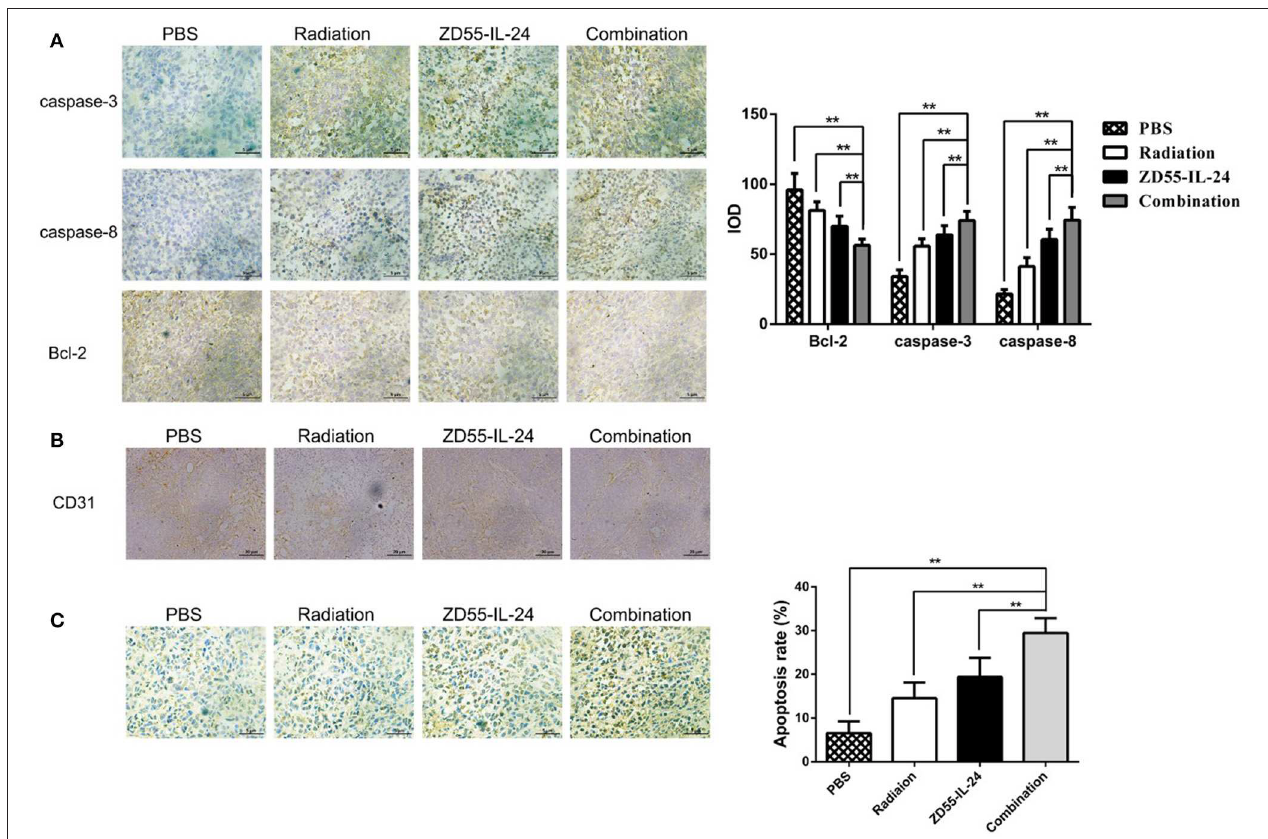
FIGURE 5 | Combination of ZD55-IL-24 and radiation induced the apoptosis of xenografts. (A) Immunohistochemistry staining of Bcl-2, caspase-3, and caspase-8 in xenografts of different groups (400 × ). (B) CD31 staining of xenografts in each group of mice. (C) TUNEL staining of apoptotic cells in xenografts of different groups (400 × ). 1, PBS; 2, radiation; 3, ZD55-IL-24; 4, combination of ZD55-IL-24 and radiation. ** P < 0.01 vs. combination group.